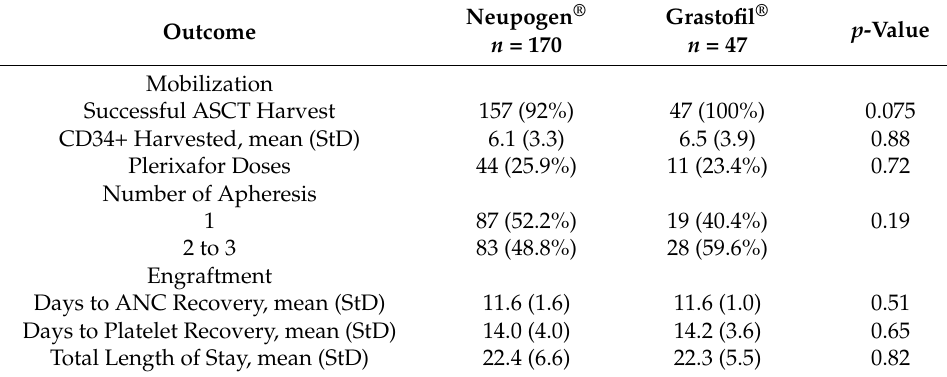
Table 2. Mobilization and Engraftment Outcomes.